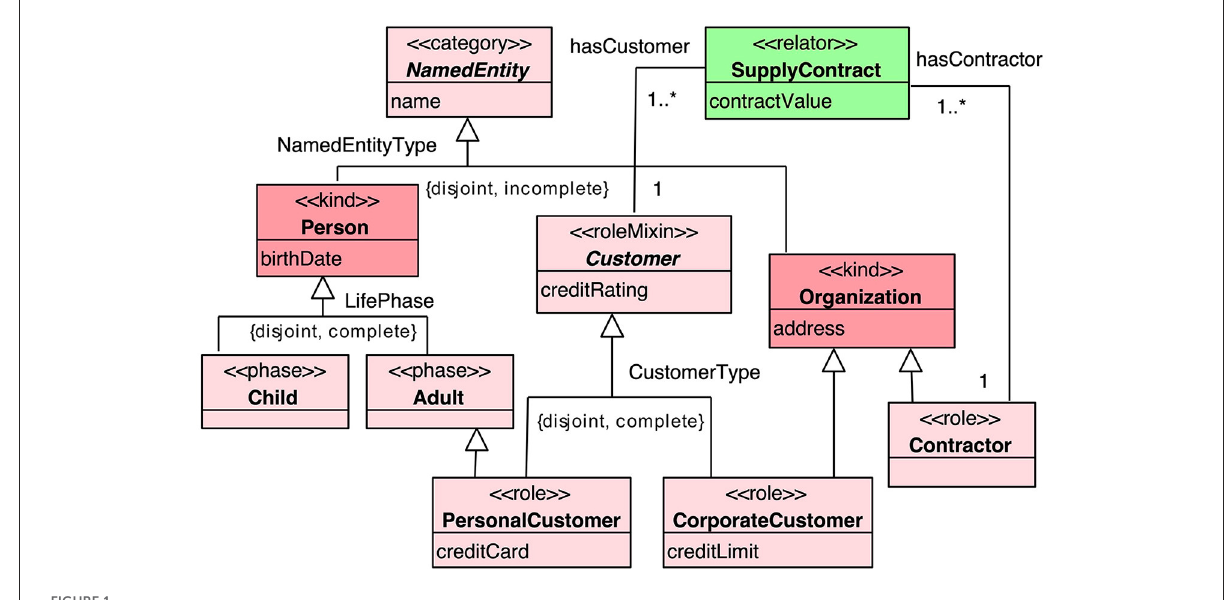
FIGURE1 Example source conceptual model.